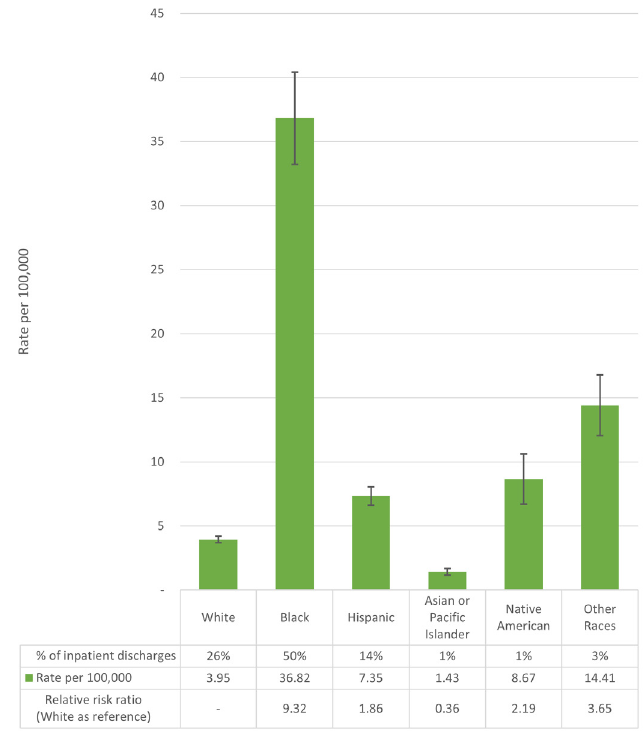
Figure 4. Row proportion, rate per 100,000 population, and relative risk of nonfatal firearm injury episodes requiring inpatient admission for the United States, by combined race and Hispanic origin, 2016-2018, calculated from inpatient discharges in the National Inpatient Sample. Lines represent 95% confidence intervals for weighted survey